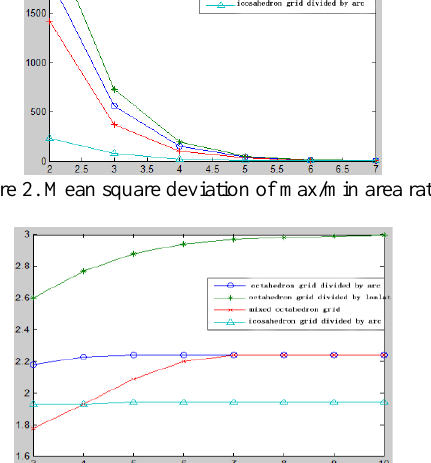
Figure 8. The planar distribution of icosahedron grid divided by